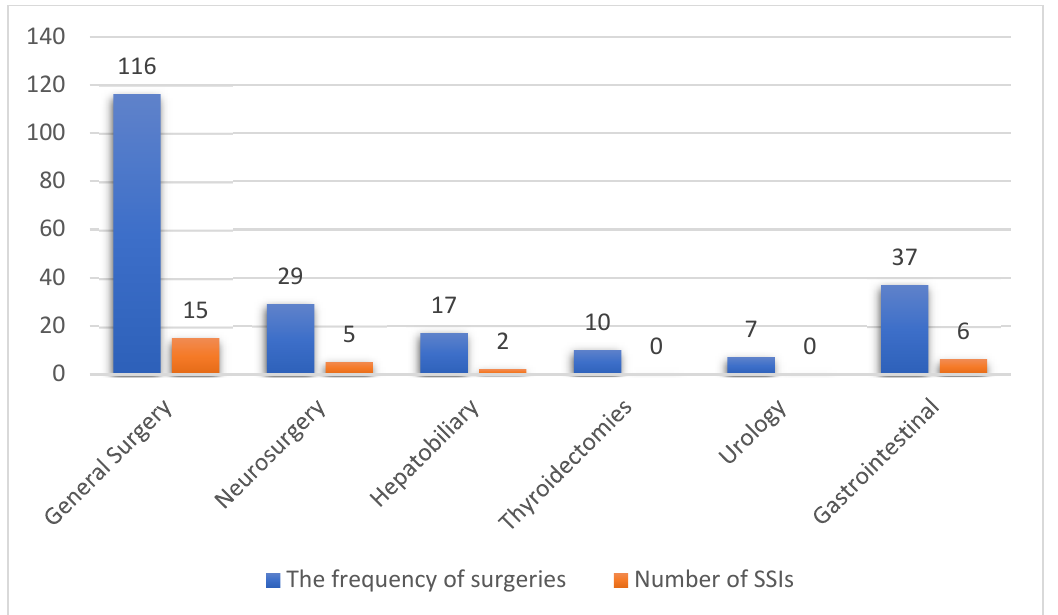
Figure 2. The incidence of SSIs. The bar chart represents the number of surgeries by category and the number of surgical site infections (SSIs) for each category.